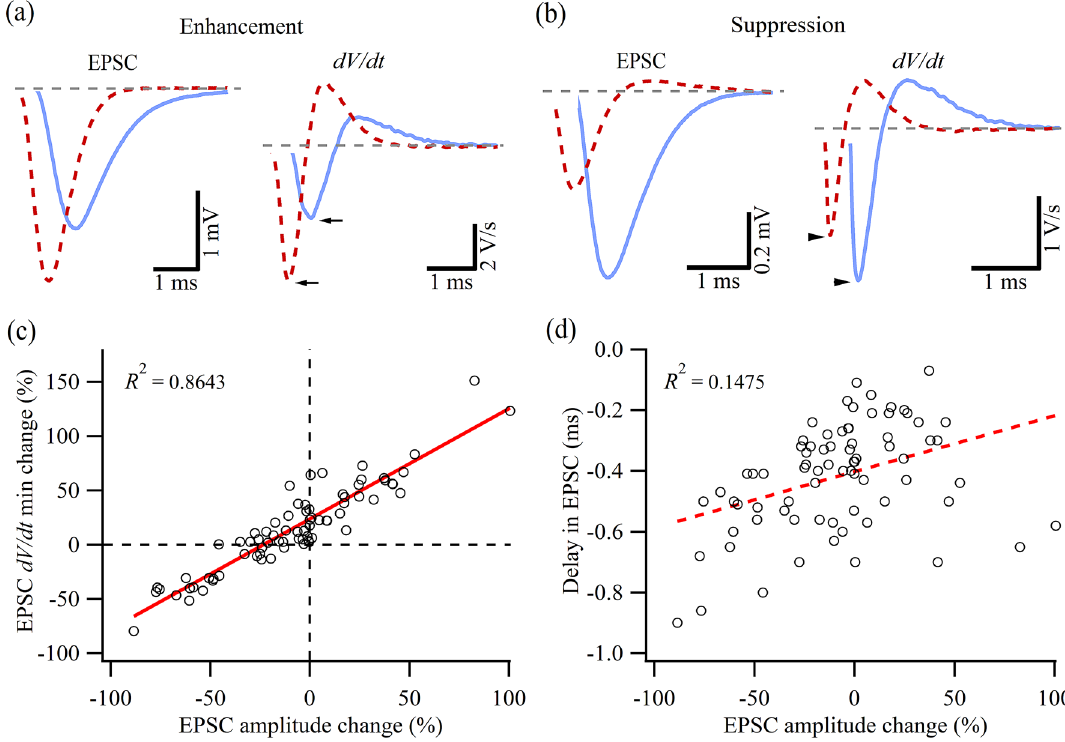
Figure 4. Dynamic changes of the IR light-modulated EPSCs. ( a , b ) Comparison of the EPSCs with (dashed red line) and without (solid blue line) IR light pulse illumination and their corresponding dV/dt traces for two scenarios: one with the EPSC amplitude enhanced by the IR light pulse ( a ) and the other suppressed ( b ). Each trace was averaged over 50 trials. ( c ) Scatter plot showing a positive correlation between the IR light-induced EPSC amplitude changes and the IR light-induced EPSC dV/dt minimum changes. ( d ) Scatter plot of the IR light-induced EPSC amplitude changes against the IR light-induced EPSC delays measured using the time when the dV/dt minimum occurs. Data in ( c ) and ( d ) are collected from 15 animals under different IR light power levels with Protocol 1 and Protocol 2. EPSCs whose amplitude was suppressed by more than 90% were not included in the